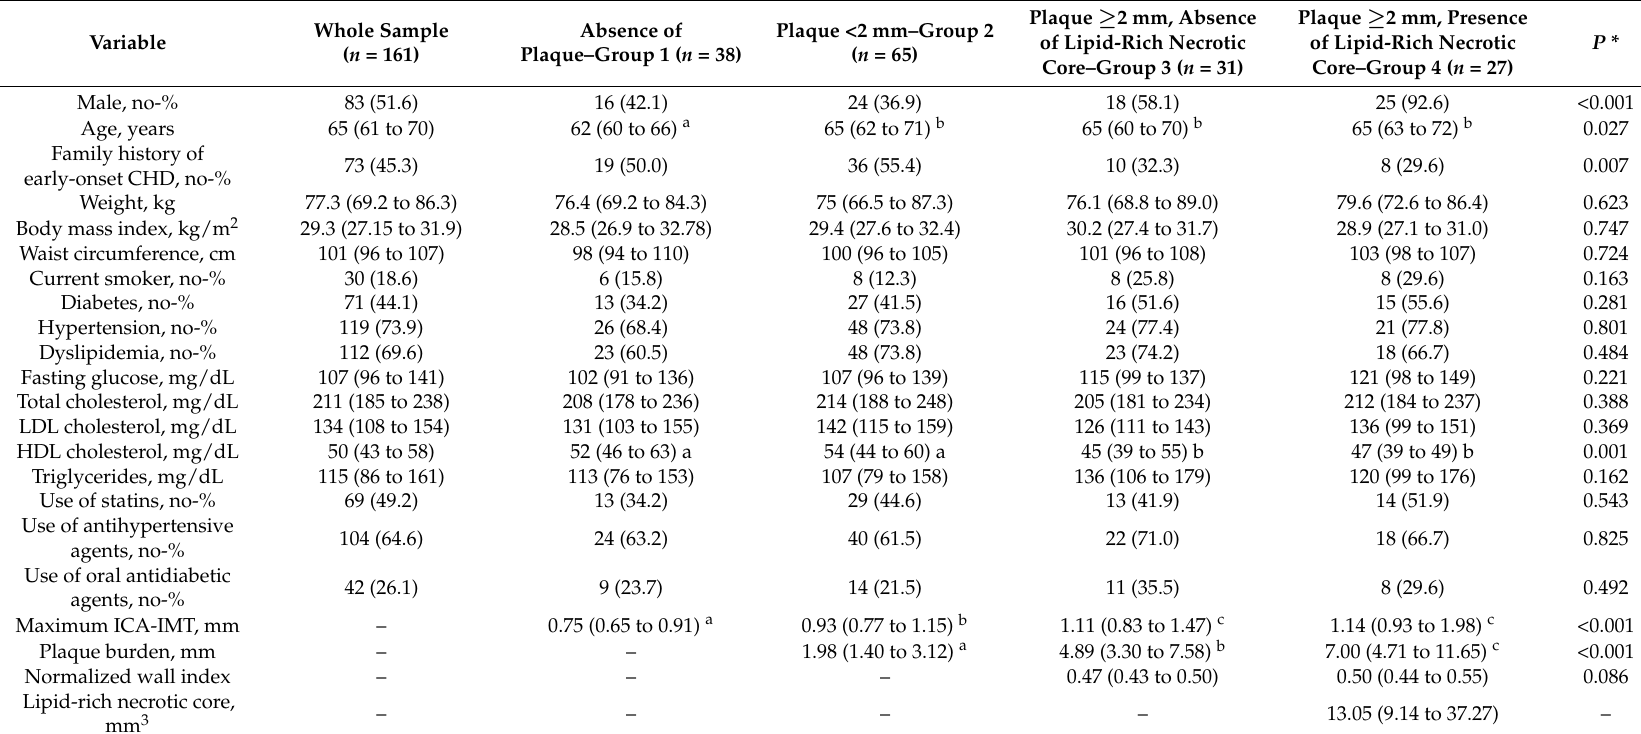
Table 1. Participants’ clinical and laboratory characteristics, treatment regimes and carotid